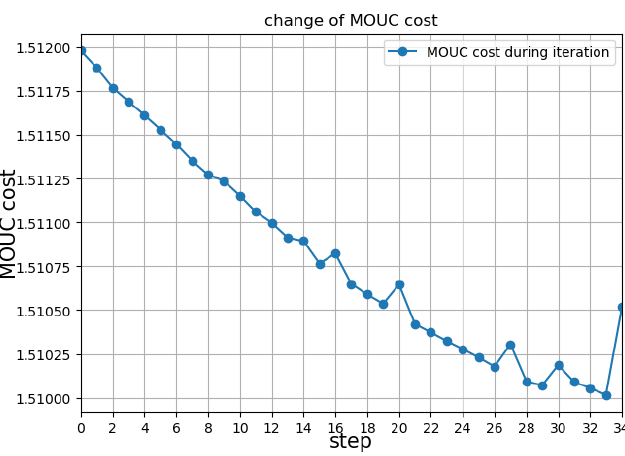
Figure 3. Margin price during iteration process.